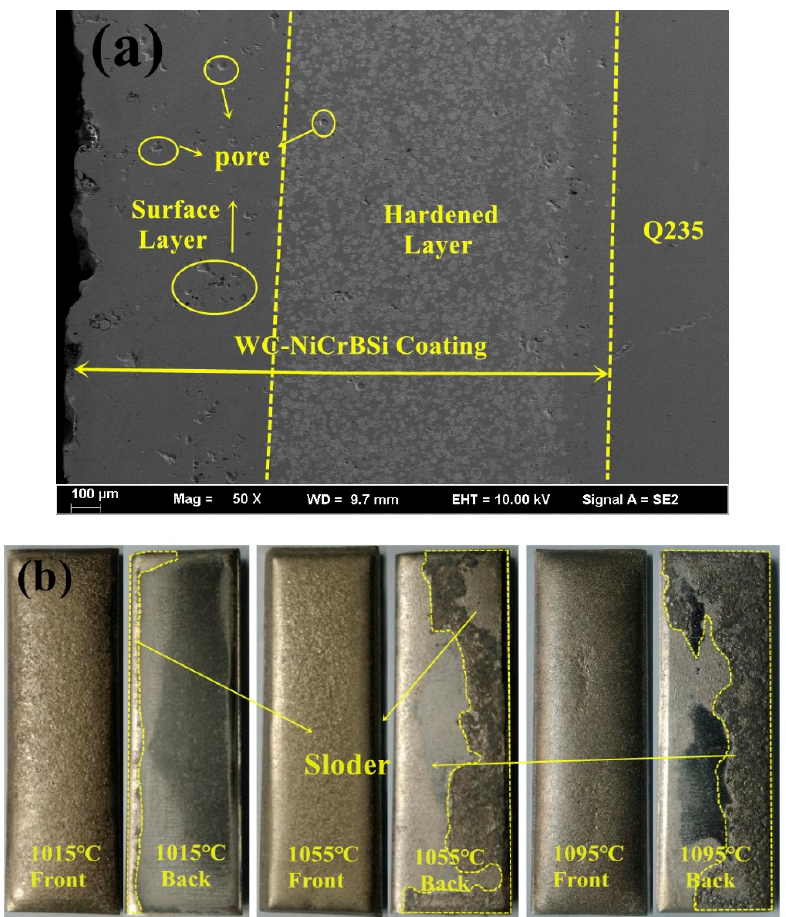
Figure 6. ( a ) Micromorphology of the coating with a soldering temperature of 1055 °C ; ( b ) The front and back morphology of